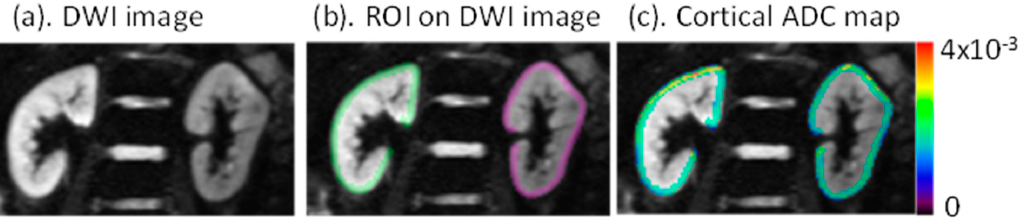
Figure 2. ( a ) Representative diffusion-weighted image. ( b ) Manually defined regions of interest (ROI) on left and right kidneys. Color identifies ROIs individually on the left and right kidneys. ( c ) ADC maps within the cortical ROI with color bar generated by FV, indicating relative ADC values in units of mm 2 /s.